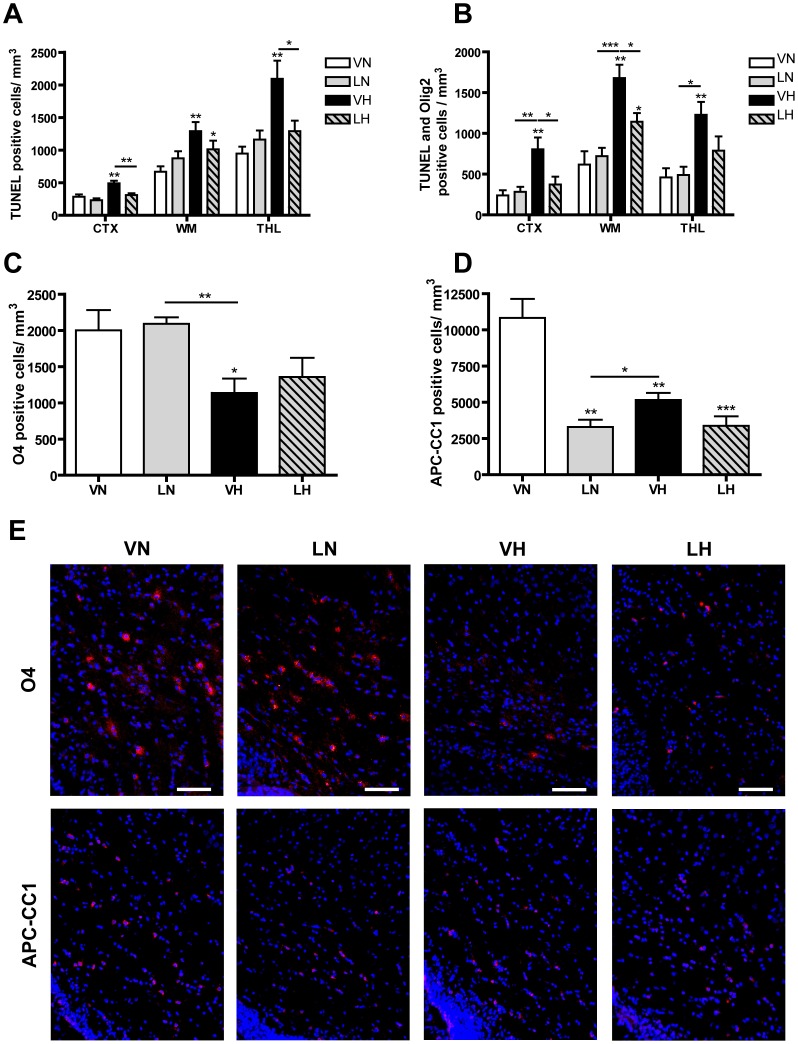
Immunohistological analysis of cell death and oligodendrocyte maturation.Hyperoxia but not LPS induce oligodendrocyte cell death revealed by TUNEL-staining. (A) LPS pre-treatment prior to hyperoxia reduce number of TUNEL-positive cells in CTX, WM and THL (LH, dashed bars). LPS application slightly increases number of TUNEL-positive cells in WM and THL but not in CTX (LN, grey bars), whereas hyperoxia affects all probed brain regions strongly (VH, black bars). TUNEL-positive cells were counted by two blinded observers in 5 sections per animal and 4 randomly assigned fields of each region per section. (B) A co-labeling with Olig2 and TUNEL shows that LPS do not induce oligodendrocyte death (LN, grey bar). Hyperoxia induces oligodendrocyte death (VH, black bar) and LPS pre-treatment reduces hyperoxia induced cell death (LH, dashed bar). (C) Hyperoxia (VH, black bar) but not LPS (LN, grey bar) causes a loss of O4-positive cells. Pups underlying the two-hit scenario exhibit a decreasing tendency of O4-positive cells (LH, dashed bar). (D) In all treated groups the number of APC-CC1-positive cells is decreased. (E) Representative images of O4- and APC-CC1 staining are shown. Scale bar = 100 µm. Mean+SEM were presented as TUNEL-positive cells/mm3 with n = 9–11 animals per group. * p<0.05, ** p<0.01and *** p<0.001; VN: vehicle+normoxia, LN: LPS+normoxia, VH: vehicle+hyperoxia, LH: LPS+hyperoxia.